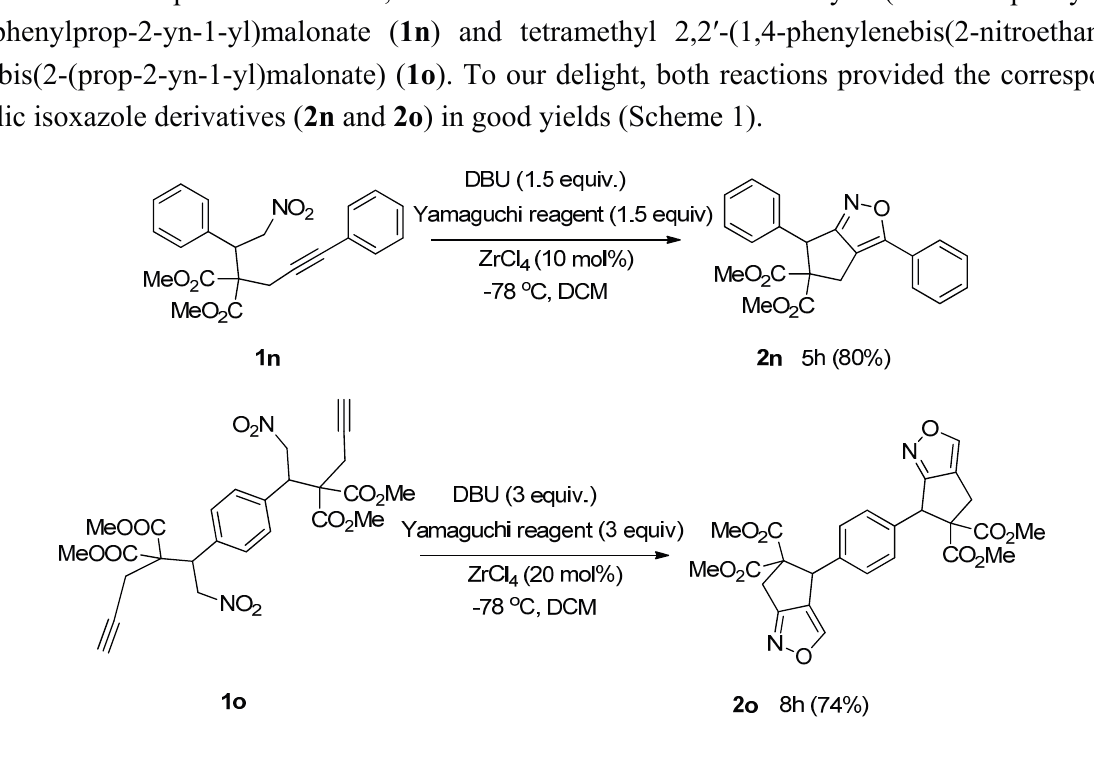
Scheme 1. Synthesis of bicyclic isoxazole